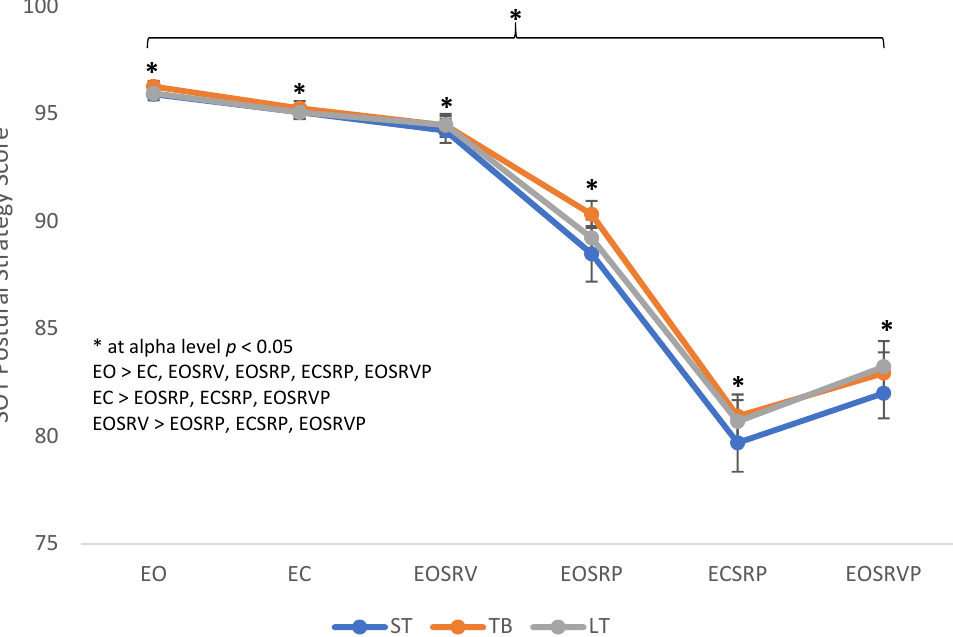
Figure 2. Sensory organization test (SOT) postural strategy scores for three types of footwear: steel-toed work boot (ST), tactical work boot (TB), and low top shoe (LT), during the six SOT conditions: eyes open (EO), eyes closed (EC), eyes open sway referenced vision (EOSRV), eyes open sway referenced platform (EOSRP), eyes closed sway referenced platform (ECSRP) and eyes open sway referenced vision and platform (EOSRVP). * indicates significant difference for SOT conditions. List within the graph explains the significant pairwise comparisons. Significant differences at p < 0.05 level; bars represent standard errors.